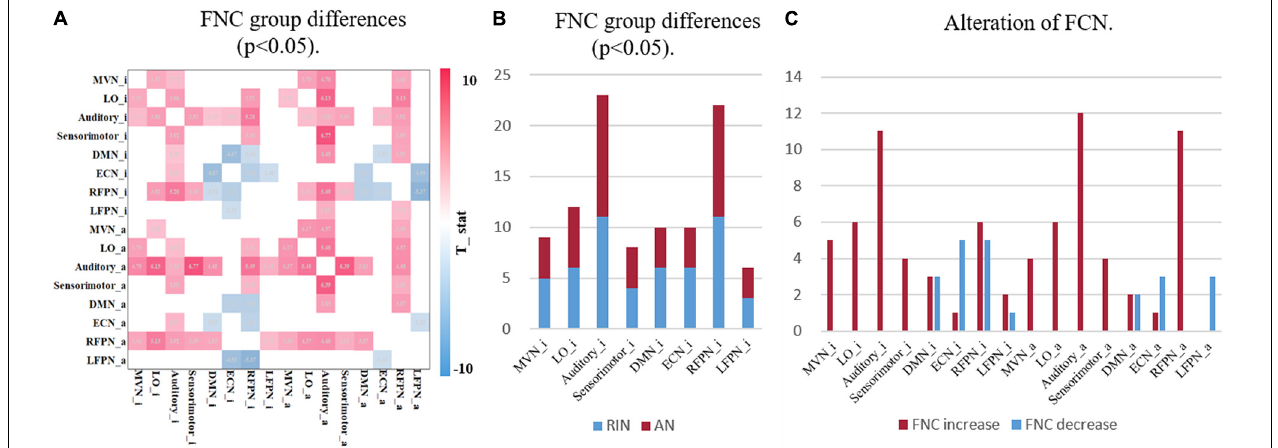
FIGURE 6 | Group differences in functional network connectively. (A) The FNC with significant differences between HCs and ADHD patients under the two-sample t -test. Only the case of p < 0.05 (FDR corrected) is shown here, where red indicates that the FNC of ADHD patients is stronger than that of HCs, and blue indicates that the FNC of ADHD patients is lower than that of HCs. (B) The statistical result of a significant alteration in FNC. The horizontal axis is the functional network, and the vertical axis is the number of alterations FNCs. RIN, relatively inert network; AN, activation network. (C) The statistics of enhanced and weakened network connectivity of FNC. Both with µ = 3. FNC, functional network connectivity; HC, healthy control; ADHD, attention deficit hyperactivity disorder; FDR, false discovery rate.